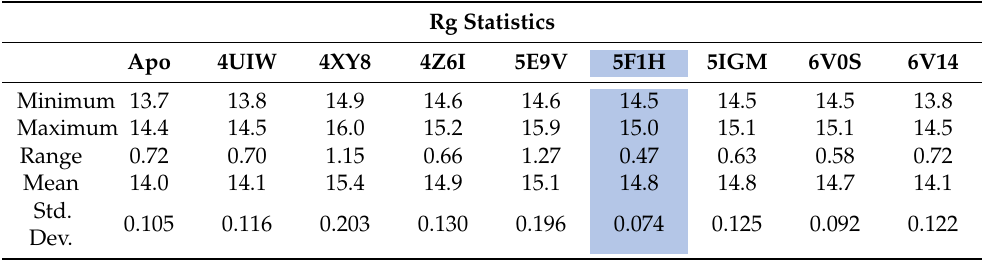
Table 5. Statistical analysis of the Rg values. The complex showing the lowest range and standard deviation value is